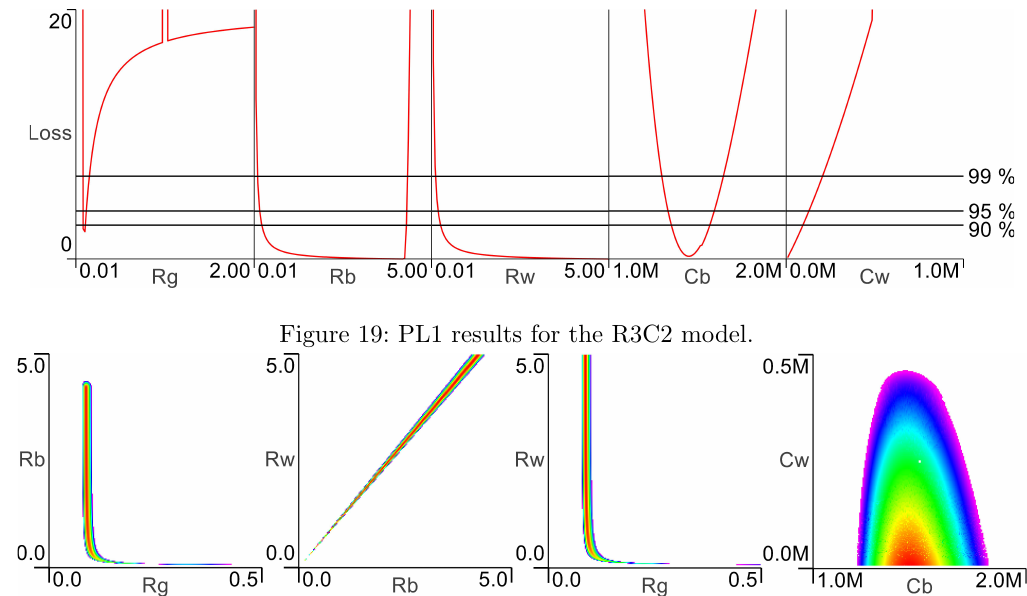
Figure 20: Selected PL2 results for the R3C2 model shows that the parameters R w and R b are inter-dependent.